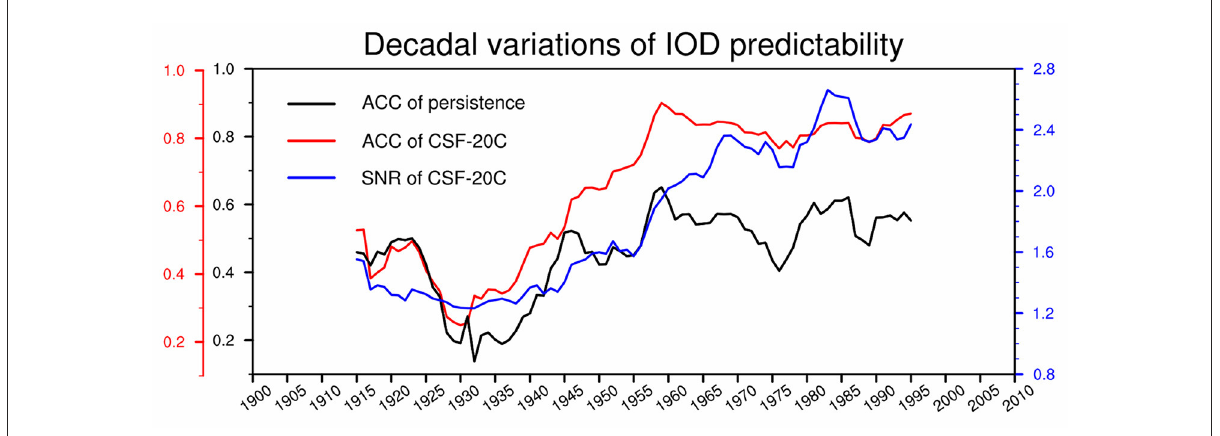
FIGURE8 The 30-year moving-window ACC skill of SON-mean DMI for the CSF-20C predictions (red line) and the persistence predictions (black line). The signal-to-noise ratio (SNR) of the predicted SON-mean DMI calculated by the 30-year moving window for 1901 − 2010 is shown in the blue line. The persistence predictions of SON-mean DMI derived from the observational May-June-July mean